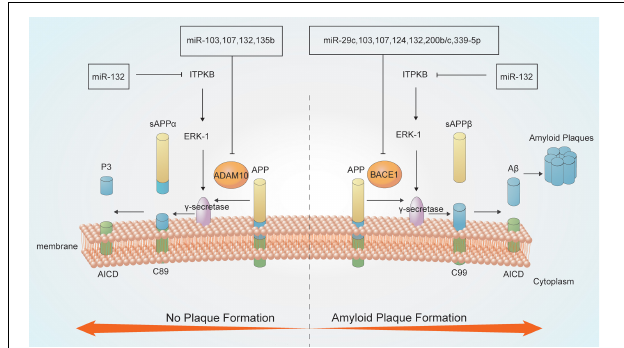
FIGURE 1 | MicroRNAs (miRNAs) are involved in A β metabolism. Amyloid precursor protein (APP) is a type I integral inner membrane-localized protein. Under normal conditions, APP is hydrolyzed by α -secretase to produce the neuroprotective soluble external functional fragments (sAPP), P3 and the APP intracellular domain (AICD) (no plaque formation); in contrast, β -secretase-mediated APP hydrolysis generates plaque-forming A β , which is neurotoxic. The γ -secretase enzyme is crucial for both secretase